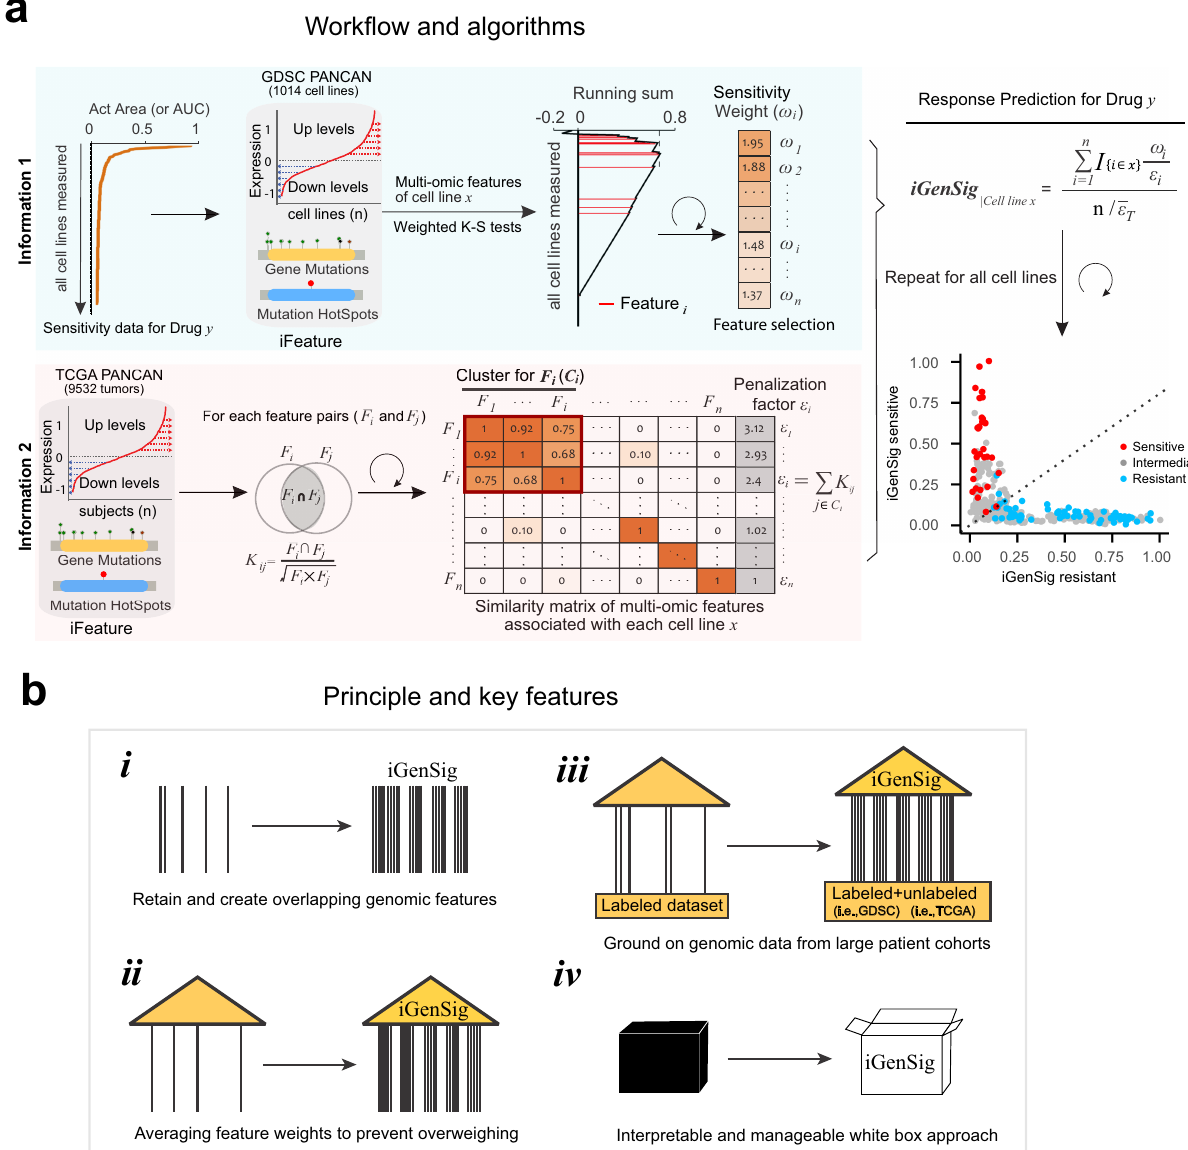
Fig. 1 The principle, work fl ow, and algorithms of the integral genomic signature modeling approach. a The work fl ow and algorithms of integral genomic signature analysis. The upper panel shows the calculation of the weights for signi fi cant genomic features that predict drug sensitivity or resistance based on weighted K-S tests of Act Area or AUC for each drug respectively, and the lower panel shows the computation of a similarity matrix for genomic features based on TCGA Pan-Cancer dataset to penalize the redundancy between the genomic features associated with each cell line x . The resulting sensitive or resistant genomic signature scores are calculated separately using the weights predictive of sensitivity or resistance respectively based on the indicated formula. The dot plot shows the sensitive and resistant iGenSig scores for all cell line subjects, with red and blue colors indicating sensitive and resistant cell lines. b Schematic showing the principle and key features of iGenSig modeling: (i) the iGenSig approach intentionally retains and creates redundant genomic features, a concept like the use of redundant steel rods to reinforce the pillars of a building. (ii) iGenSig modeling utilizes the average correlation intensities of signi fi cant genomic features detected in speci fi c samples to diminish the effect of false-positive detection resulting from sequencing errors and prevent overweighing. (iii) iGenSig modeling extracts the second genomic information from unlabeled genomic datasets for large cohorts of human cancers, in addition to the labeled genomic datasets of drug sensitivity, which will substantially improve its cross-dataset applicability, particularly on clinical trial datasets. (iv) iGenSig modeling is a white-box approach, thus will be more interpretable and controllable than machine learning or deep learning A total of fi ve train/test sets are generated for modeling through random permutations. We then performed iGenSig modeling for 364 drugs that elicit a negatively skewed drug response distribution in cancer cell lines indicating the narrow effect of outstanding responses and have at least 20 sensitive cell line subjects indicating the availability of outstanding responders. To